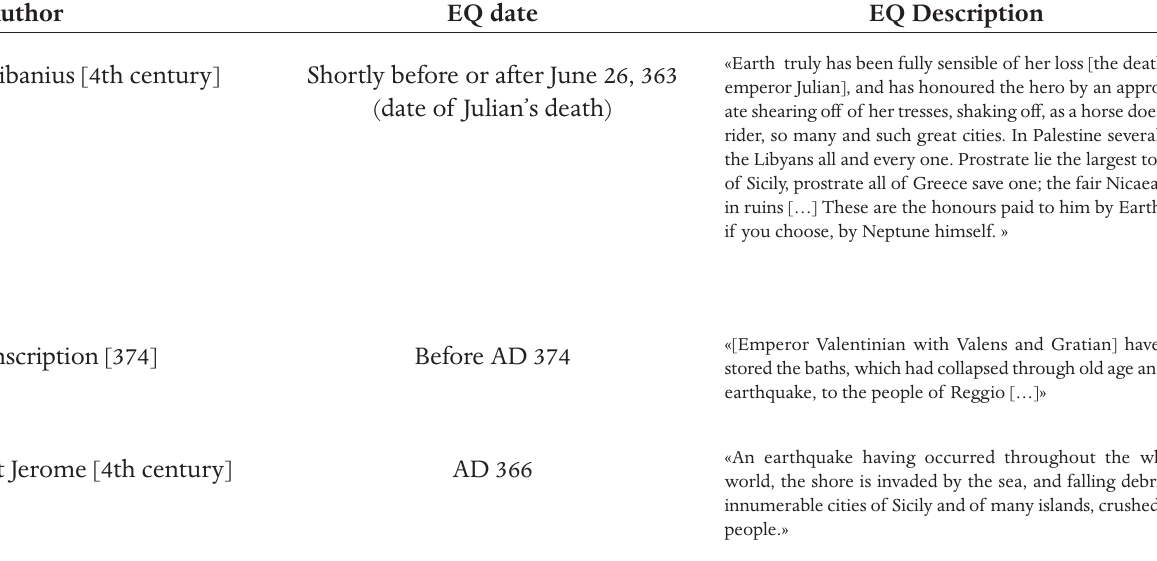
Table 5. Original information on earthquakes occurred in the third quarter of the 4th century